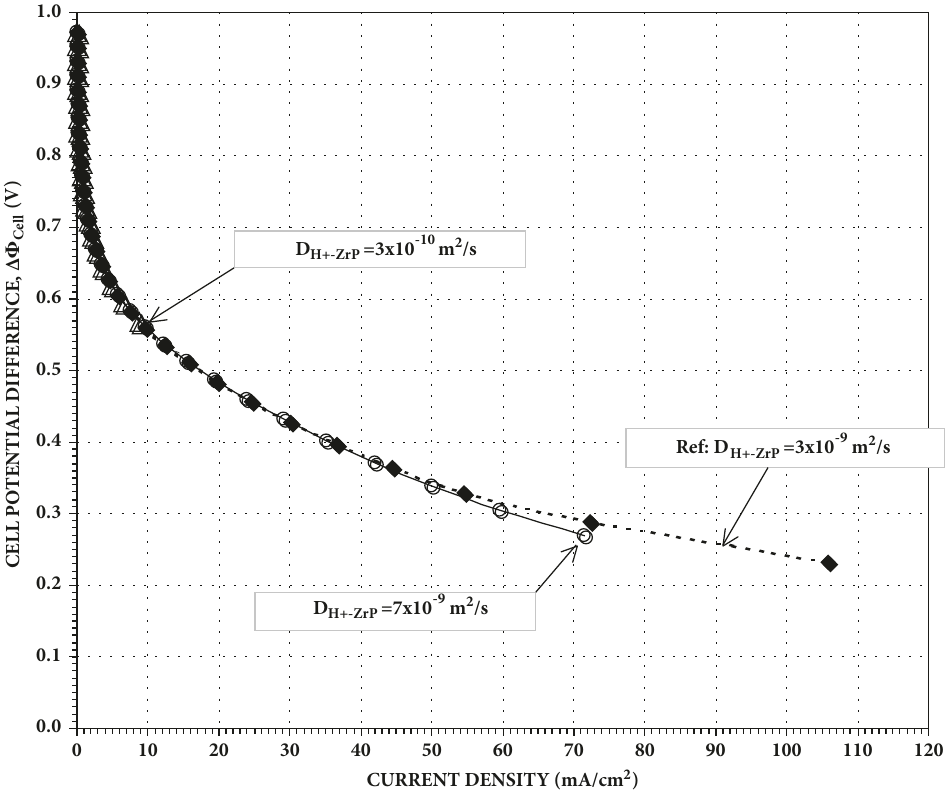
Figure 8: The effect of the proton diffusivity coefficientin the electrolyte phase, D (m 2 /s), on the polarization curve for a direct propane H + - ZrP fuel cell (DPFC) model at 150 ∘ C and 1 atm. The values of D (m 2 /s) for the above three cases were represented by the following symbols: H + - ZrP (i) open triangles: 3x10 −10 m 2 /s, (ii) solid diamonds: 3x10 −9 m 2 /s (reference case), and (iii) open circles: 7x10 −9 m 2 /s. All the other parameters were the same as the reference case mentioned in Table